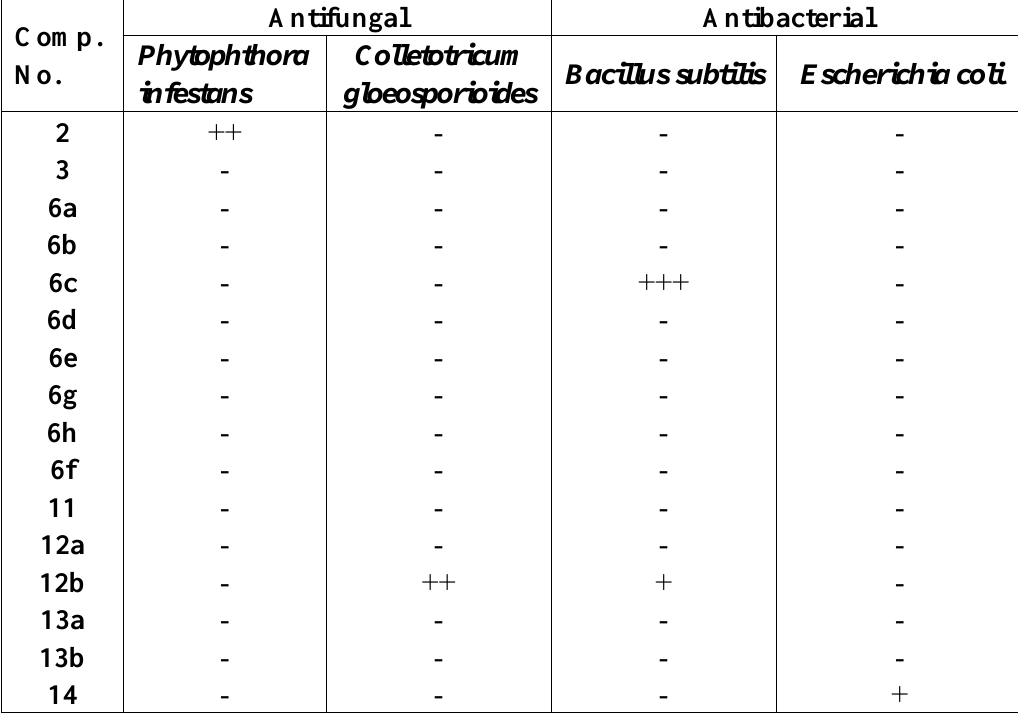
Table1. Antimicrobial activity of triazole